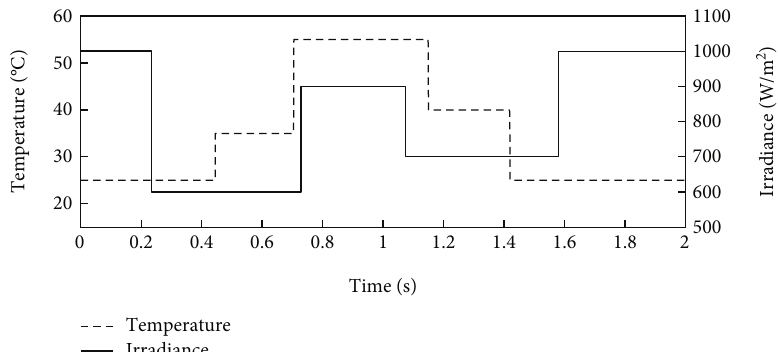
Figure 14: Fast-changing environmental conditions.